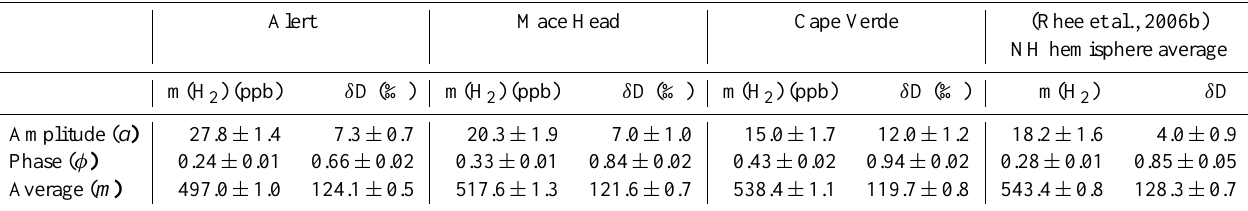
Table 3. The obtained fitting parameters for a least-square fit with a harmonic function to the data from Alert, Mace Head and Cape Verde ( y = a cos ( 2 π(x − φ)) + m)